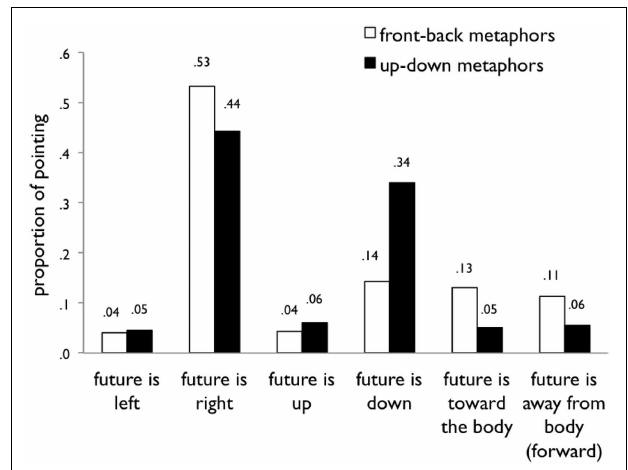
FIGURE 3 | Results of Study 2 broken down by direction. The graph shows the proportion of arrangements in six directions (whether time was arranged with the future to the left, right, above, below, away from or toward the body with respect to the reference point) when participants were cued with front-back or up-down metaphors.